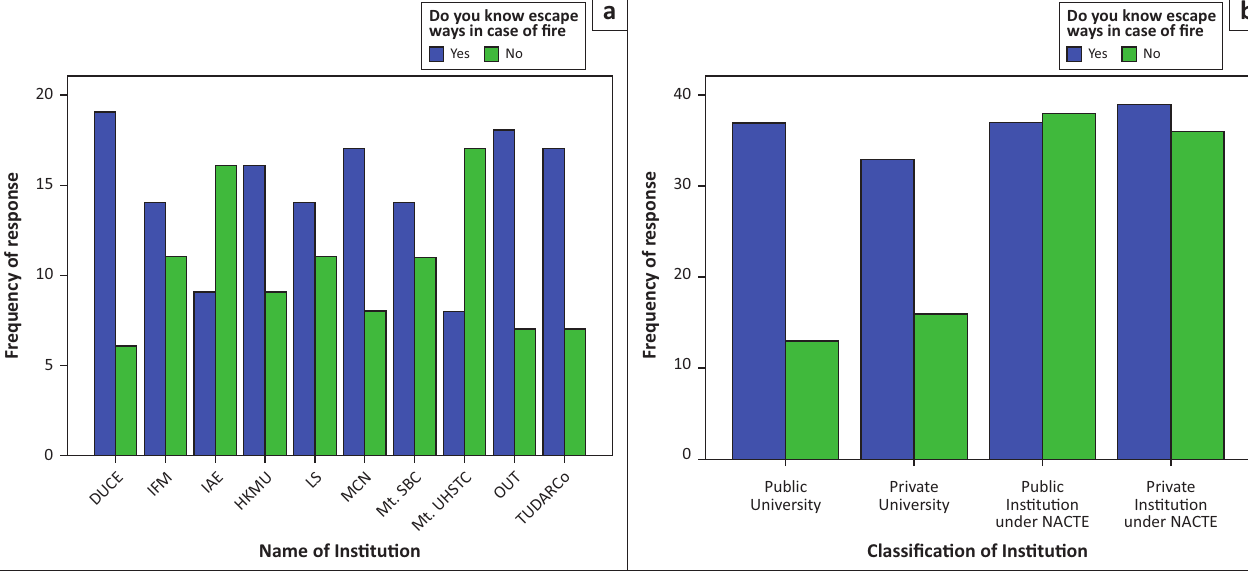
FIGURE 2: Knowledge on the location of the escape ways. (a) Responses per institution and (b) responses per institution category.